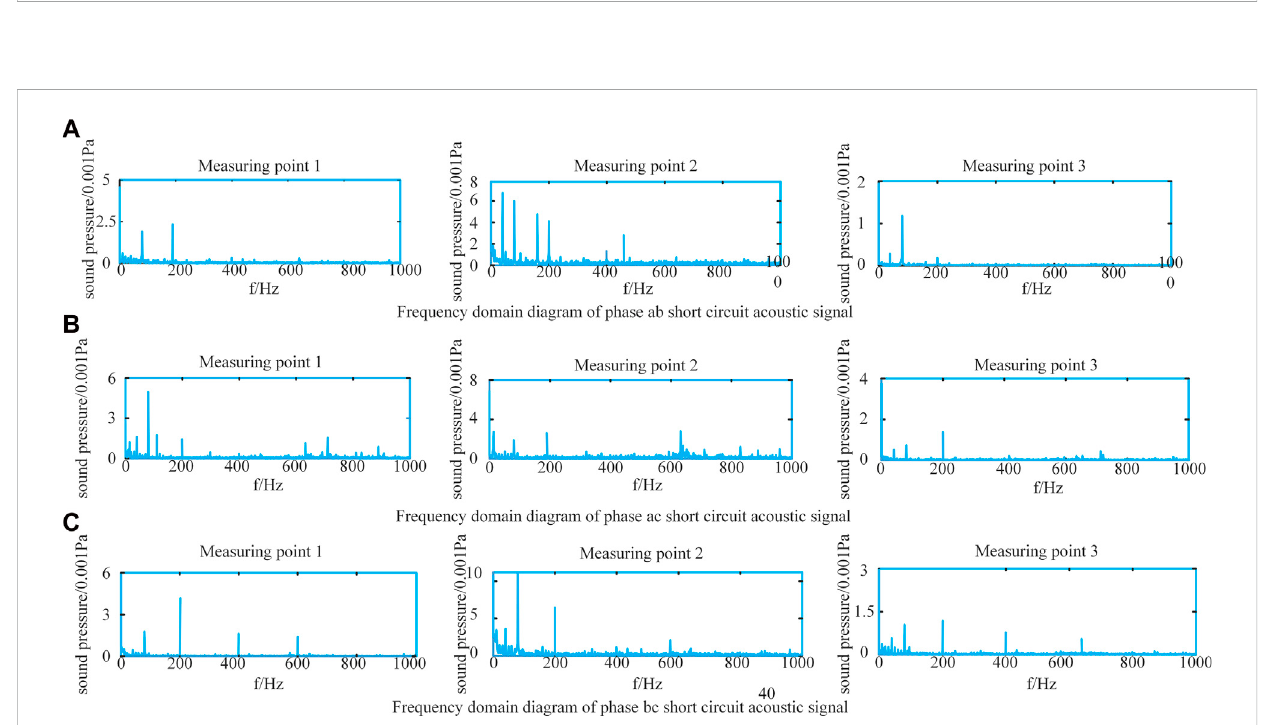
FIGURE 3 Frequency distribution of acoustic signal in two-phase short circuit of transformer